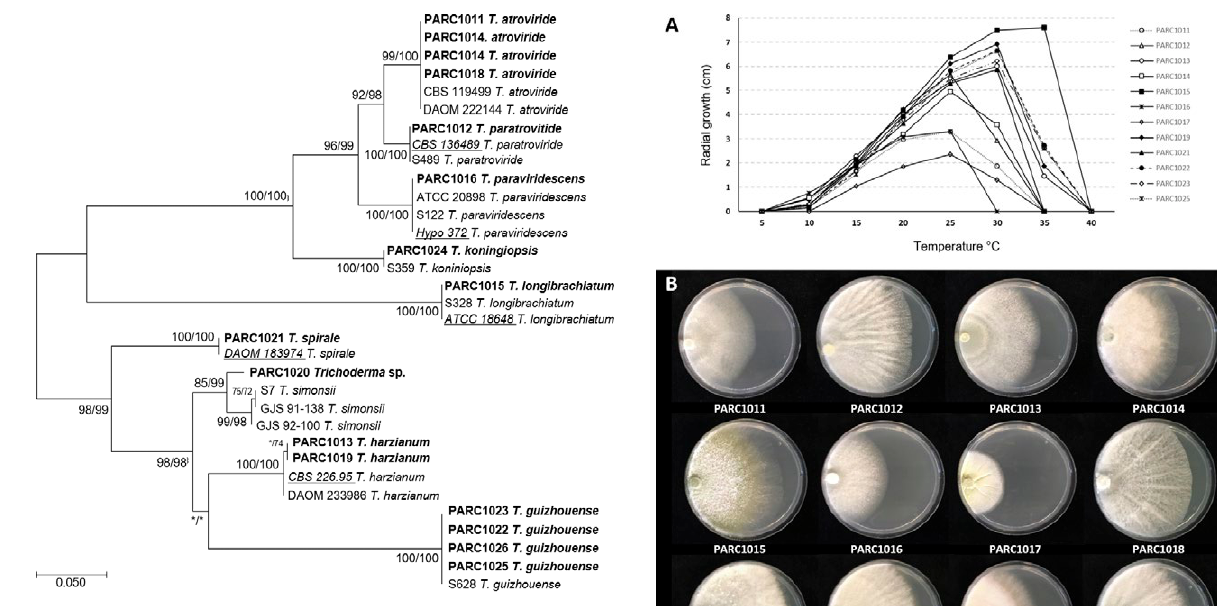
Figure 3. Greatest log likelihood RPB2 Neighbor-Join phylogenetic tree generated with 33 Trichoderma nucleotide sequences. Num- bers in before and after each slash (/) represent, respectively, likeli- hood and parsimony bootstrap values from 1,000 replicates. Values accompanied by an asterisk were less than 70% bootstrap. Tricho- derma isolates from southern Italy included in this study are indi- cated in bold. Ex-type isolates are indicated in underlined italics.